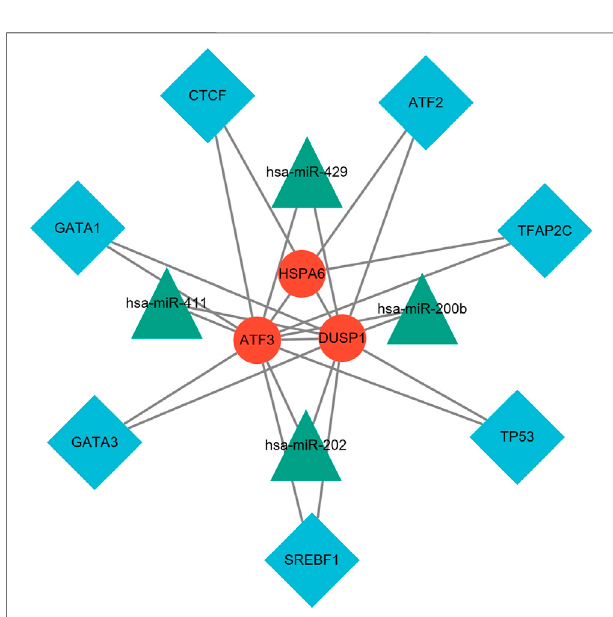
FIGURE 10 | TF – miRNA coregulatory network. The network consisted of 14 nodes and 23 edges, including seven TF genes and four miRNAs, and three validated hub genes. The red round nodes are validated hub genes, the blue diamond nodes are TF genes, and the green triangle nodes are miRNA